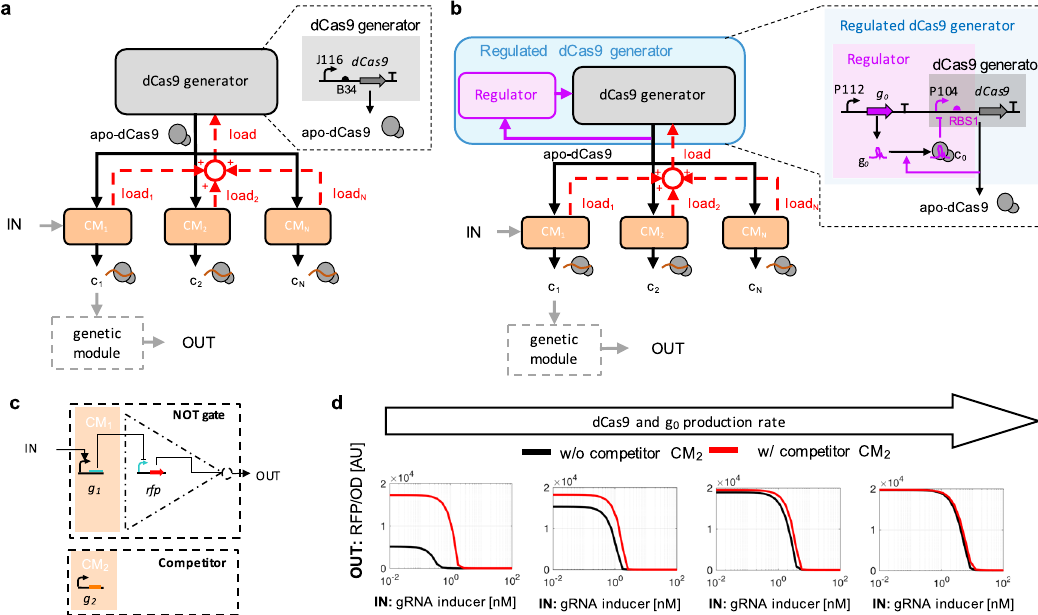
Fig. 1 Regulated dCas9 generator mitigates loads in CRISPRi-based genetic circuits. a Block diagram of unregulated (UR) dCas9 generator subject to load and corresponding genetic implementation. An unregulated dCas9 generator produces apo-dCas9 at a pre- fi xed constant rate. A CRISPRi module (CM) takes apo-dCas9 as a resource input, comprises a sequence speci fi c sgRNA, and produces the sgRNA-dCas9 complex c i as a transcriptional repressor output. A CM typically takes regulatory inputs (see CM 1 ) that control the expression of the sgRNA. The repressor c i can serve as a regulatory input to another CM or to a module expressing a protein (genetic module). The sequestration of dCas9 by each sgRNA is graphically represented as a load that the corresponding CM applies to the dCas9 generator (red dashed arrows). The overall load to the dCas9 generator is the sum (open red circle) of all the loads by each CM. In the genetic implementation, the dCas9 gene is expressed by the BBa_J23116 promoter (shown as J116) and the RBS BBa_B0034 (shown as B34). b Block diagram of regulated (R) dCas9 generator subject to load and corresponding genetic implementation. A regulated dCas9 generator produces apo-dCas9 at a rate that is adjusted based on the level of apo-dCas9 itself via a regulator. In the genetic implementation, the regulator comprises constitutive expression (through promoter P112) of gRNA g 0 , which binds to dCas9 to form the dCas9-g 0 complex c 0 . This, in turn, represses dCas9 promoter (P104) through CRISPRi. dCas9 promoter P104 and RBS (RBS1) are both stronger than those of the unregulated generator. Details about parts and plasmids are reported in Supplementary Notes 3 and 6. c Logic diagram of a CRISPRi-based NOT gate. The logic is implemented through the repression of a constitutive promoter driving a reporter gene ( rfp ) by an inducible sgRNA. d Parameters controlling the performance of the regulated dCas9 generator. Simulation results show the I/O response of a CM-based NOT gate in the presence or absence of the competitor CM (see c ), as the production rate of g 0 and of dCas9 are increased. The left-side panel corresponds to a regulated dCas9 generator with no g 0 making the system like an unregulated dCas9 generator. Details about mathematical model and parameters are reported in Supplementary Note